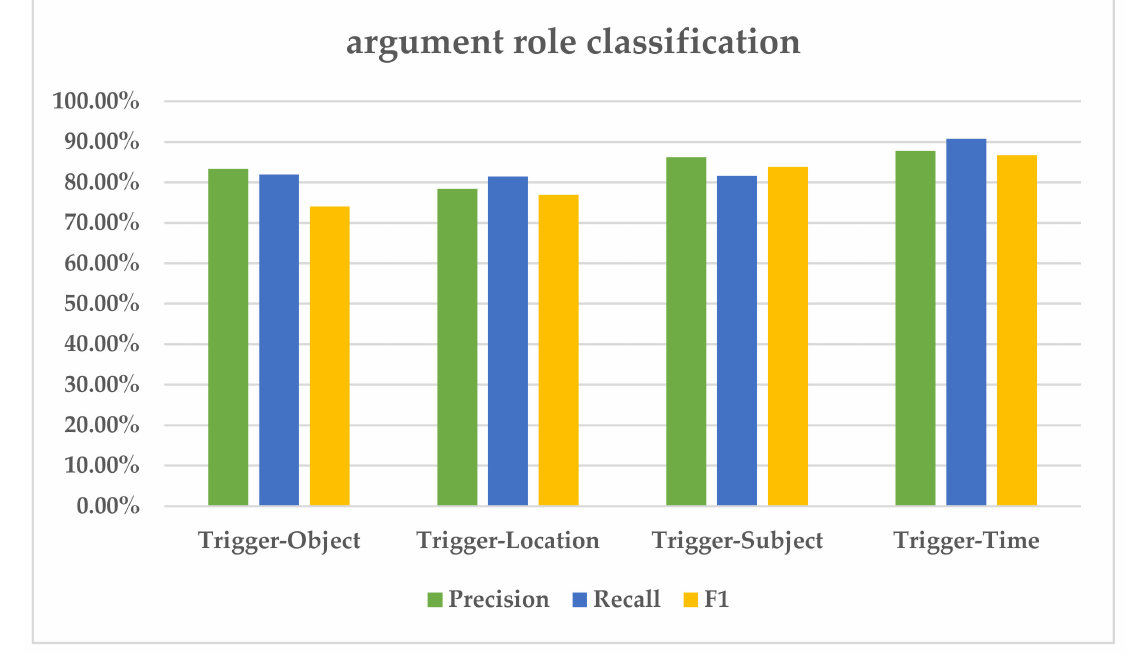
Figure 6. The results of argument role classification.